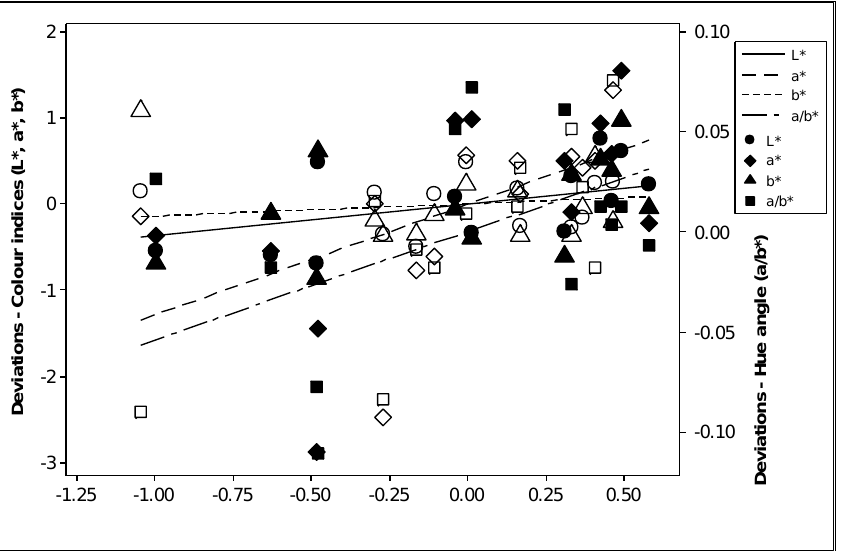
Figure 6. Correlation between the deviations from the year means for the colour indices L*, a*, b* and a/b* and the deviations from the year means for the sum of all-trans lycopene, 9 cis lycopene and β-carotene during the experimental years. Mean values = the average values of the data in each year. Deviation = the measured values minus the corresponding mean values. Solid symbols represent values in Year 1, while open symbols represent values in Year 2.